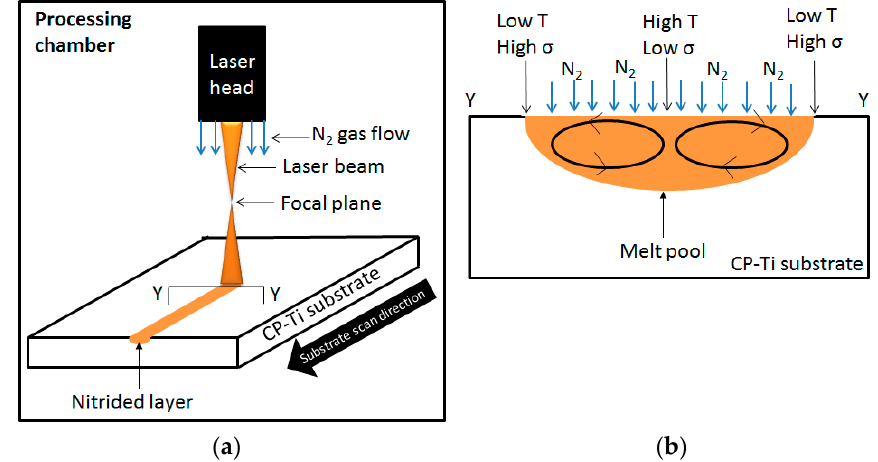
Figure 3. ( a ) Schematic of the laser nitriding process with coaxial nitrogen gas flow, and ( b ) convective transport of nitrogen in the melt pool at the transverse cross-section Y-Y. T and σ indicate temperature and surface tension respectively. CP-Ti denotes commercially-pure titanium.